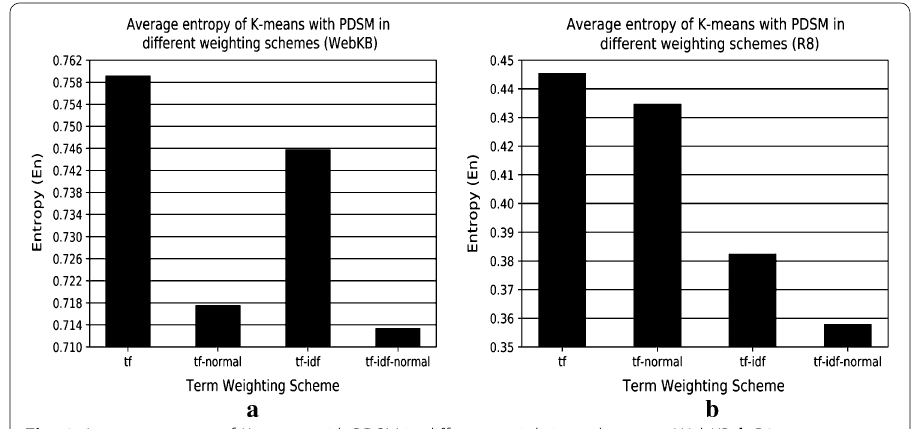
Fig. 6 Average entropy of K -means with PDSM in different weighting schemes: a WebKB. b